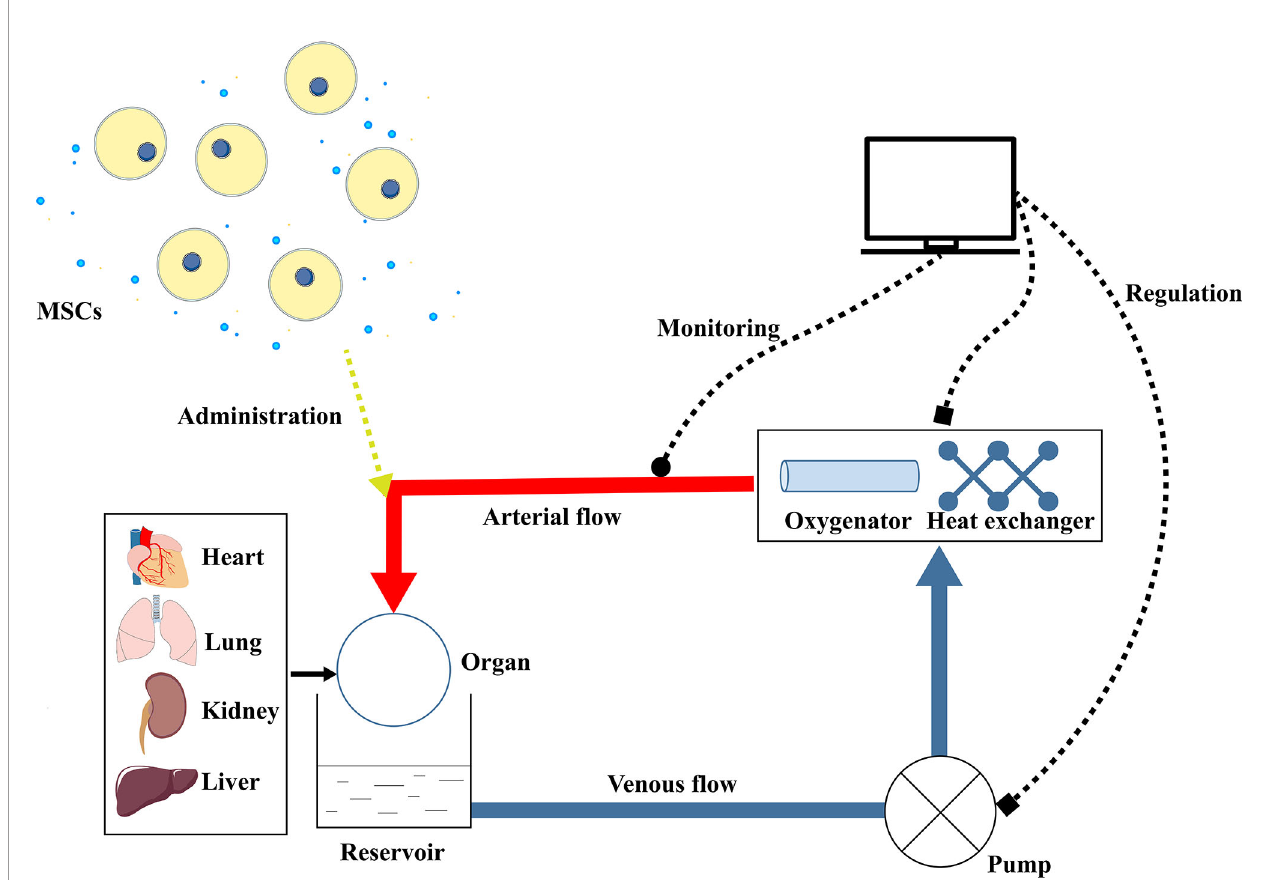
FIGURE 2 | Schematic picture of MSCs combined with machine perfusion on organ preservation and reconditioning. The machine perfusion system consists of a pump, reservoir, oxygenator, and heat exchanger. The pump can maintain a continuous fl ow to the organ (heart, lung, kidney, or liver) through the vasculature. Recycled in the circuit, the perfusate is oxygenated by the oxygenator and kept at a certain temperature by the heat exchanger. The perfusate temperature, perfusion pressure, and perfusion fl ow rate are monitored and the pump and heat exchanger are accordingly regulated. During perfusion, MSCs or their secreted factors are administered in the perfusate to the isolated organ, which is expected to ameliorate the IRI and quality of the graft. IRI, Ischemia-reperfusion injury; MSCs, Mesenchymal stem